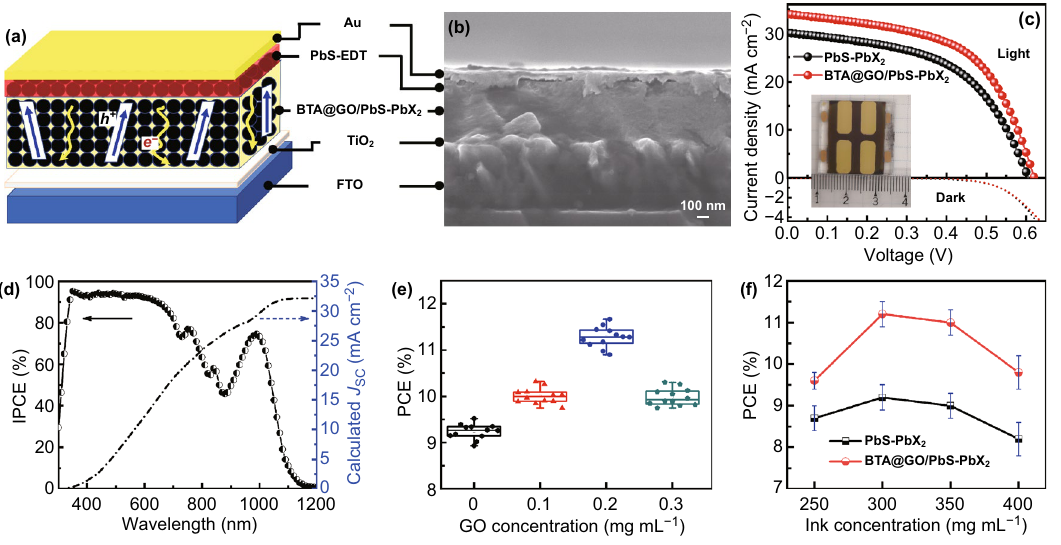
Fig. 5 a Schematic diagram of the bulk nano-heterojunction structure CQDSCs with BTA@GO/PbS-PbX 2 hybrid CQDs film. b Cross-sectional SEM image of the CQDSCs device. c J – V curves of CQDSCs based on the controlled PbS-PbX 2 CQDs film and the BTA@GO/PbS-PbX 2 hybrid CQDs film (the concentration of GO in CQDs ink is 0.2 mg mL −1 ). The inset is the photograph of CQDSCs device. d IPCE spectrum and